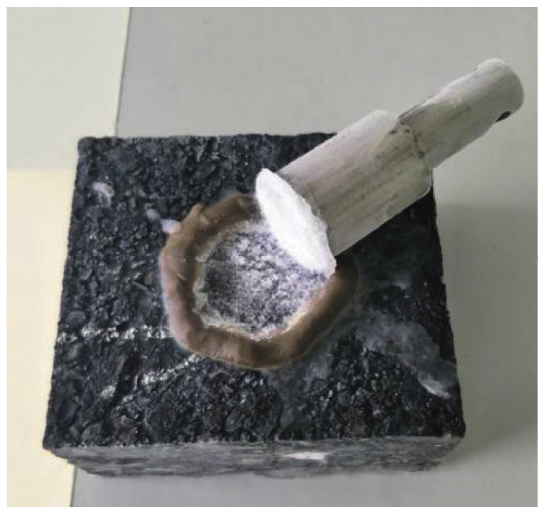
Figure 7: Pull-out test to determine tensile force at